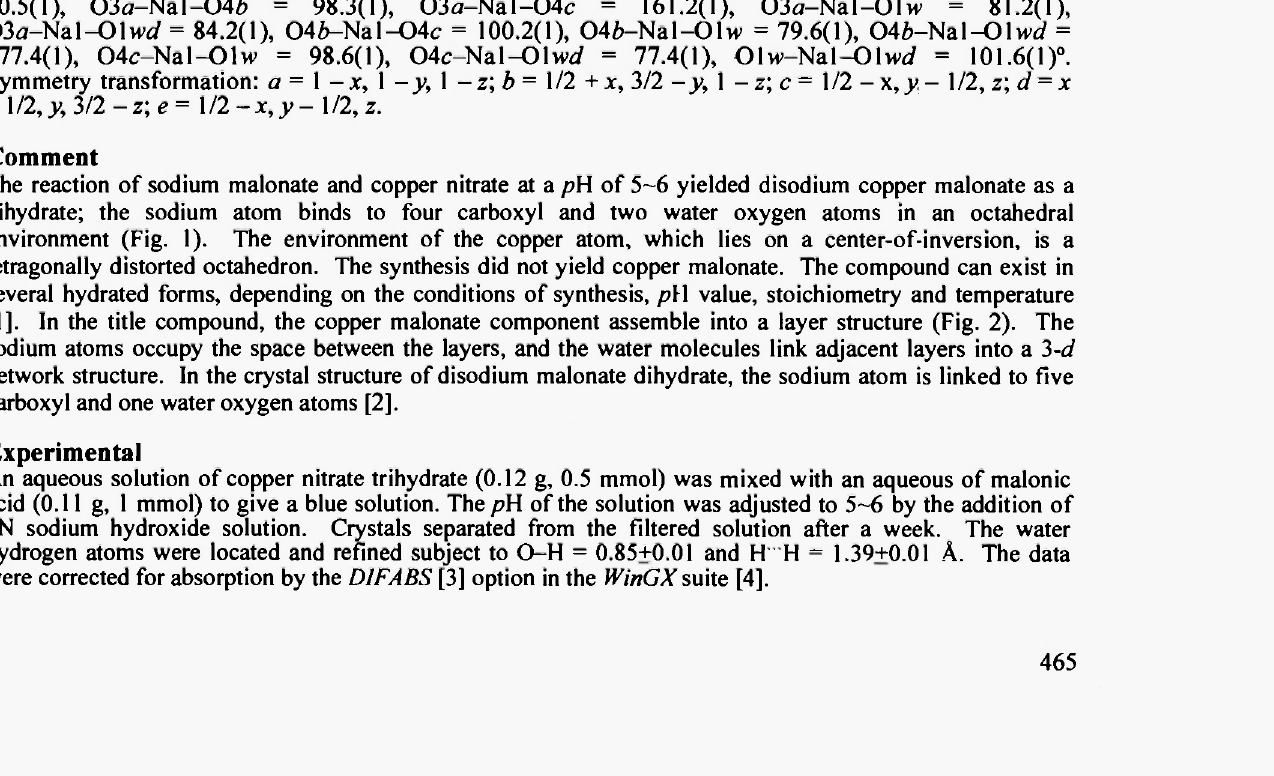
Figure 1. Geometry of the sodium and copper atoms in Na2Cu(02CCH2C02)2 2H2O. The Cul atom lies at (1/2,1/2,1,2) whereas the Nal atom lies on a general position in the crystal structure. Selected bond distances and angles: Cul-Ol = 1.950(3), Cul-02b = 2.600(3), C u l - 03 = 1.938(3), Nal-Ol = 2.445(3), N a l - 0 3a = 2.569(3), N a l - 0 46 = 2.454(4), N a l - 0 4c = 2.571(3), Nal-Olw = 2.377(3), N a l - O lW = 2.372(4) A; 01-Cul-02fc = 88.6(1), 0 1 - C u l - 0 2e = 91.4(1), 0 1 - C u l - 03 = 93.7(1), 0 1 - C u l - 0 3o = 86.3(1), 02fe-Cul-03 = 84.9(1), 02fc-Cul-03a = 95.1(1), , 0 1 - N a l - 0 3a = 64.0(1), 01-Nal-04Z> = 90.0(1), 0 1 - N a l - 0